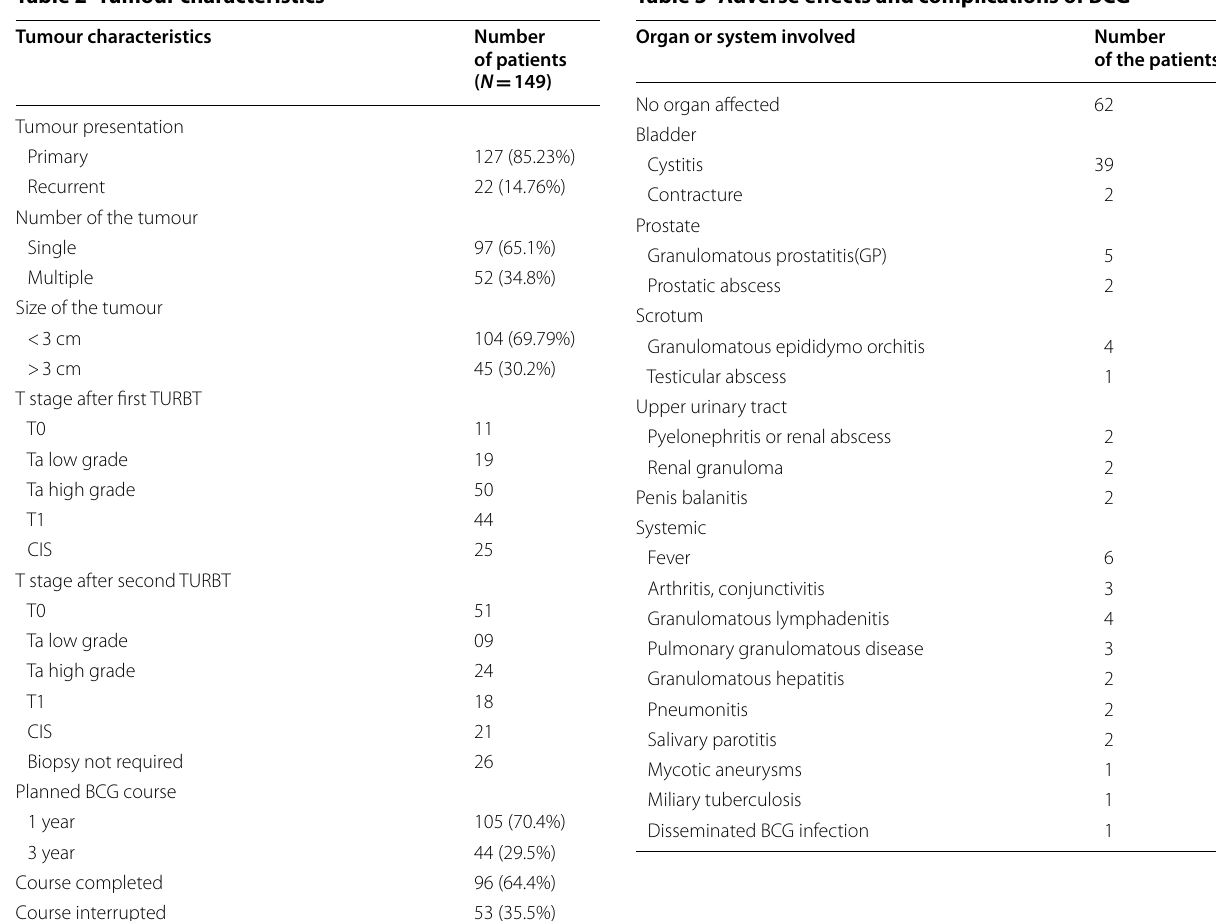
Table 2 Tumour characteristics Table 3 Adverse effects and complications of